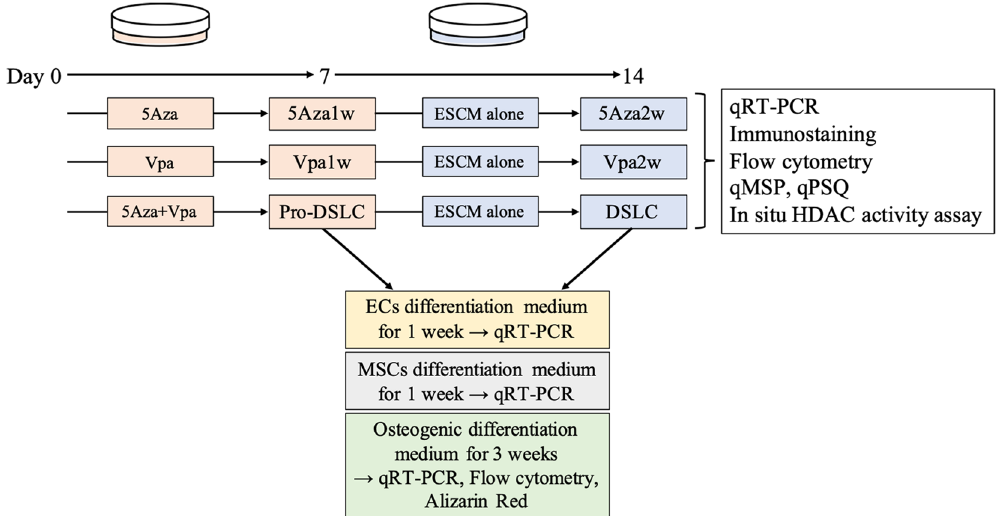
Figure 1. Schematic diagram of the whole experiment. The ERM was cultured in ESCM using culture dishes under the following conditions: 1 µM of 5Aza; and/or 2 mM of Vpa; and no additions (control) for 1